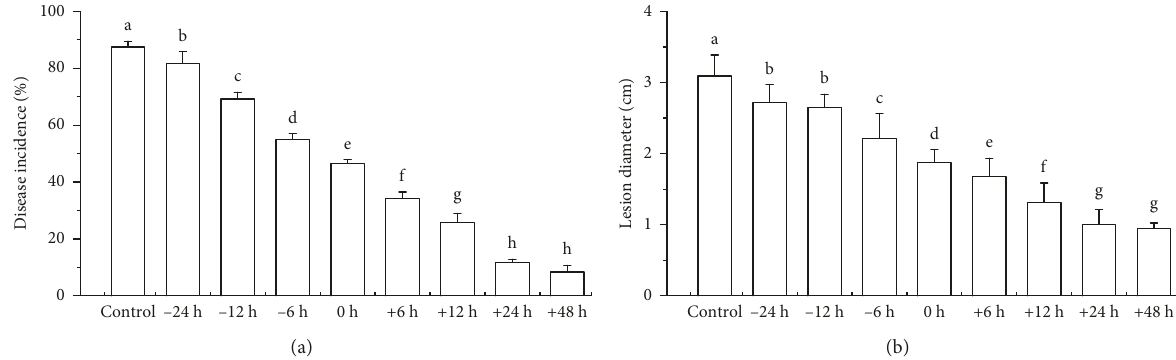
10 6 CFU/mL; III, 1 10 7 CFU/mL; IV, 1 × × × 0 . 05 <